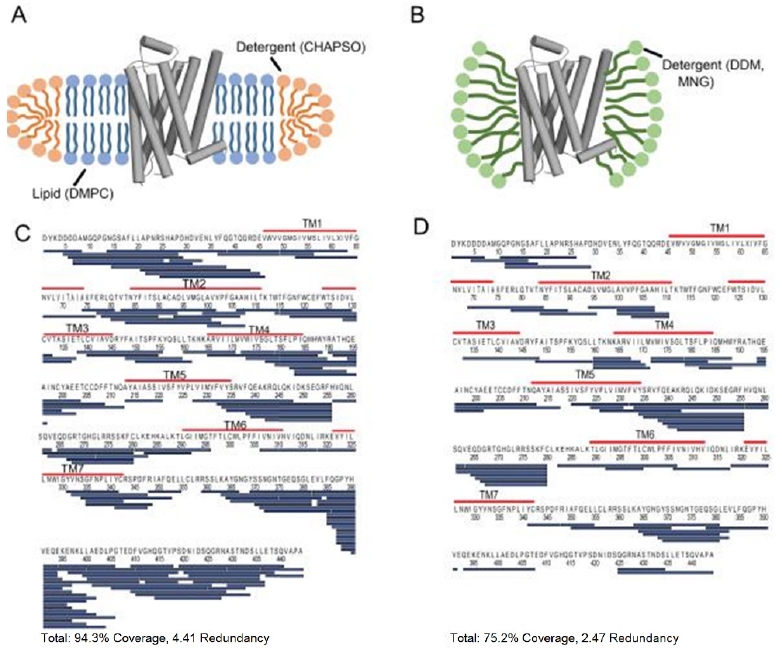
Figure 11. Cartoon illustration of β 2-Adrenergic G-protein coupled receptor (GPCR) ( β 2AR) in ( A ) a lipid bicelle (3:1 DMPC:CHAPSO) and ( B ) dodecyl maltoside (DDM). ( C ) The sequence coverage of β 2AR prepared in bicelles and ( D ) DDM. Blue bars represent peptic peptides identified from four independent experiments. Reproduced with permission from the American Chemical Society ( ©